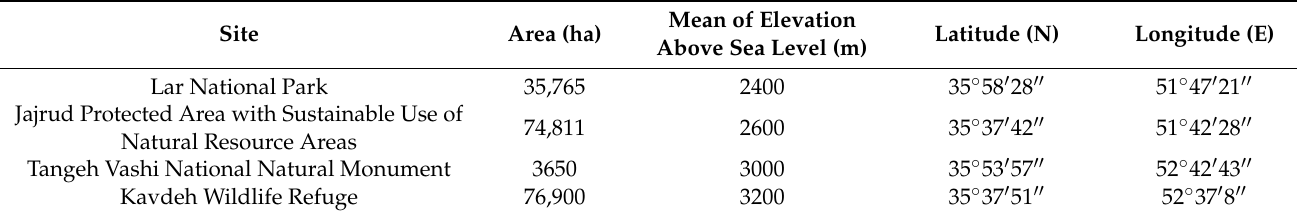
Table 1. Geographical information of the four study areas in Tehran province,